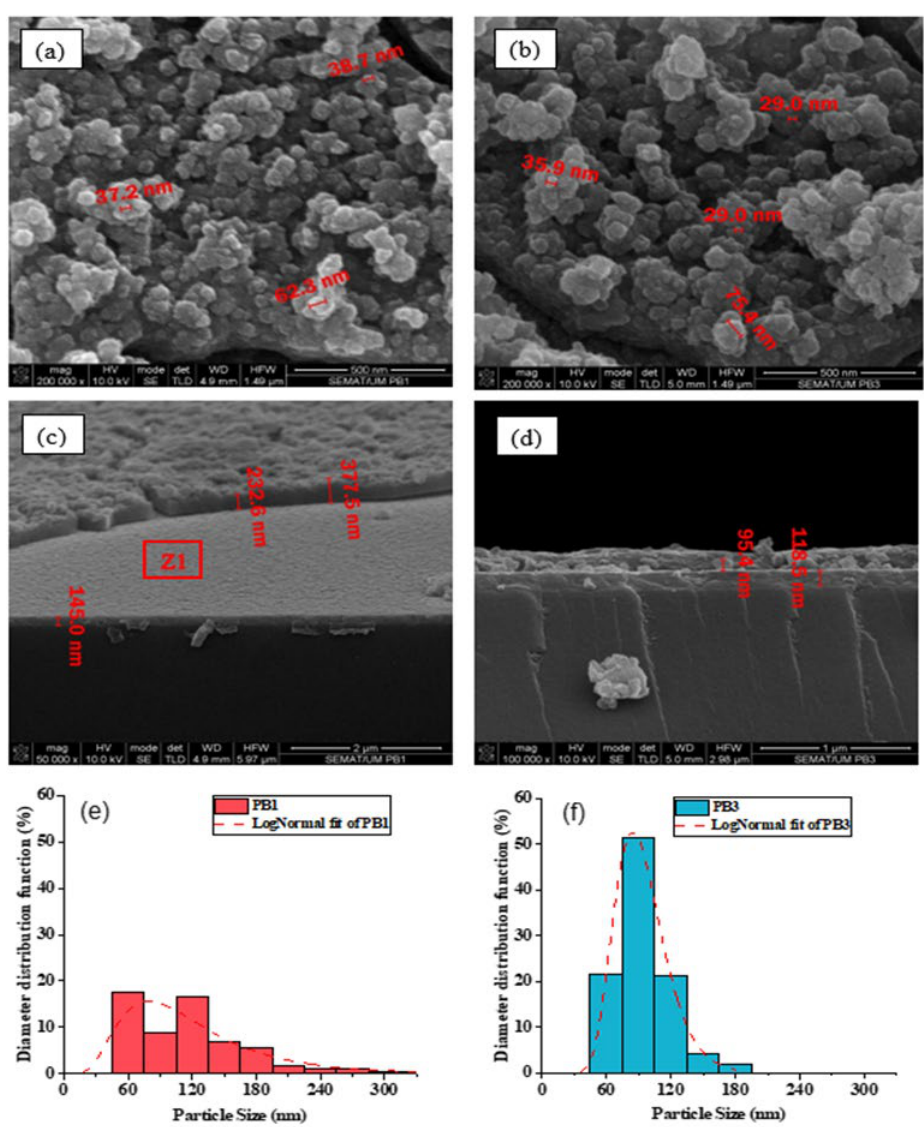
Figure 2. In ( a , b ) are the surface and in ( c , d ) are the cross-section FE-SEM images of the PB1 and PB3 samples, respectively. In ( e , f ) are the corresponding particle’s diameter size distributions. The diameter distributions are fitted with lognormal functions, which are represented by dashed